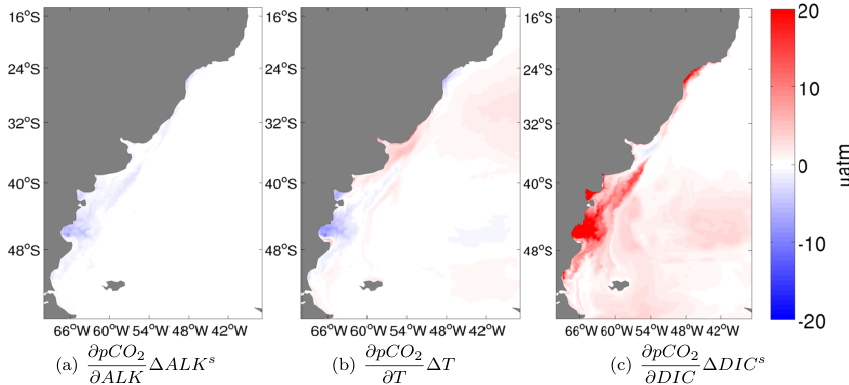
Figure 8. Sensitivity of p CO 2 computed with grid point anomalies in time to local annual means. Annual mean contribution of the main drivers: ALK s (a) , T (b) and DIC s (c) .